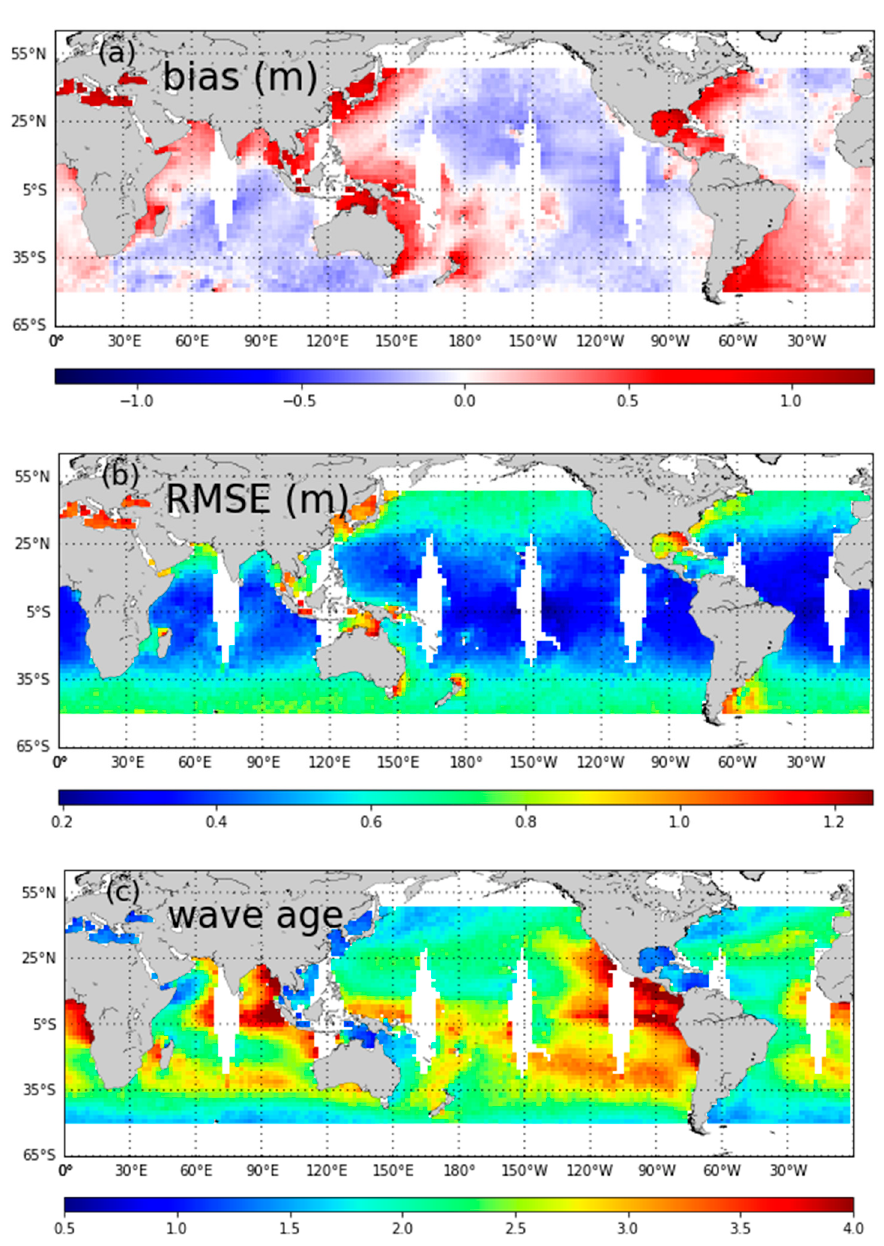
Figure 9. Map of ( a ) bias and ( b ) RMSE of deep learning ASCAT SWH estimates against WW3 hindcast and ( c ) wave age computed from WW3. All maps are on the grid of 2 ◦ × 2 ◦ . (97 ◦ W–84 ◦ W, 21 ◦ N–29 ◦ N, green box in Figure 2) and Hawaii Islands (164 ◦ W–151